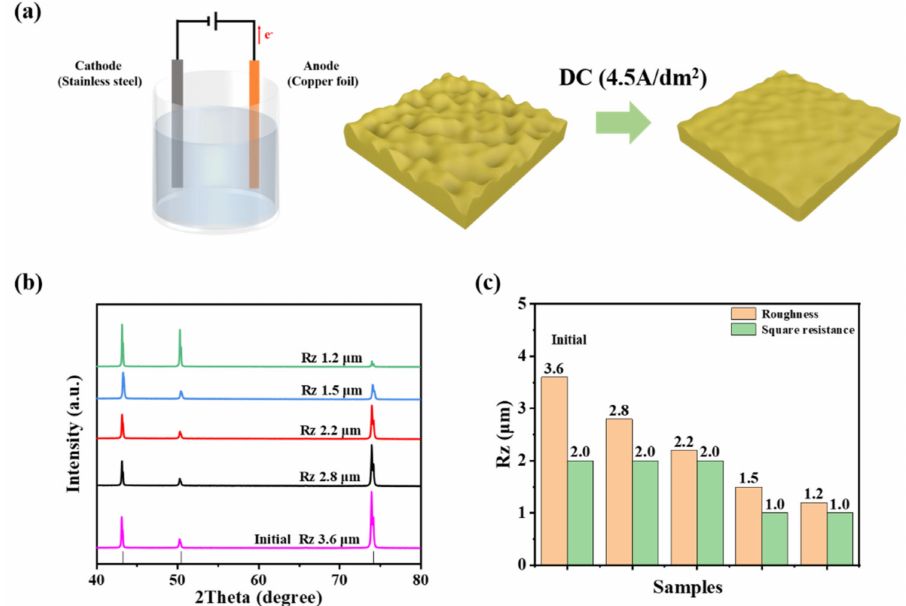
Figure 1. ( a ) Schematic illustration of the electropolishing process. ( b ) XRD for electrolytic copper foils with different surface roughness. ( c ) Specific roughness (Rz) values and sheet resistance of electrolytic copper foils with different